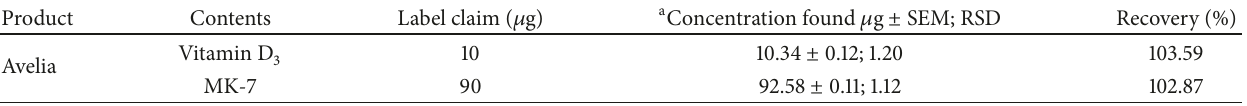
a Results are expressed as average of ten